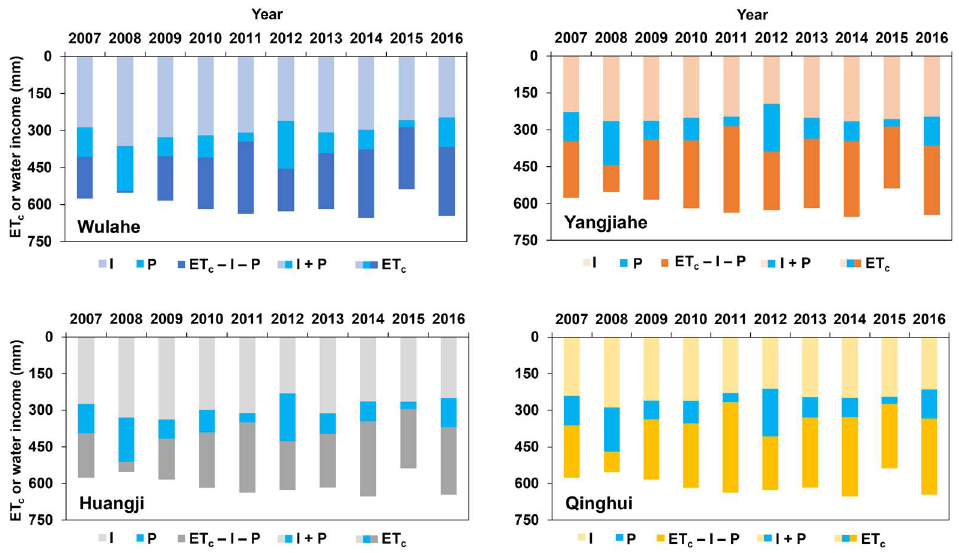
Figure 3. The cropping season precipitation (P), field irrigation (I) and potential crop evapotranspira- tion (ET c ) in the four sections in each